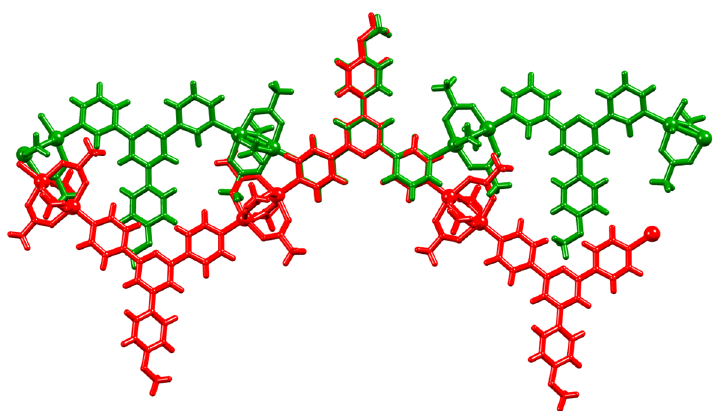
Figure 7. Overlay of parts of the 1D-coordination polymer chains in [Cu 2 ( µ -OAc) 4 ( 1 )] n (green) and [Zn 2 ( µ -OAc) 4 ( 1a )] n (red). The Cambridge Structural Database, CSD [53], refcode for [Zn 2 ( µ -OAc) 4 ( 1a )] n is SOXSEF.